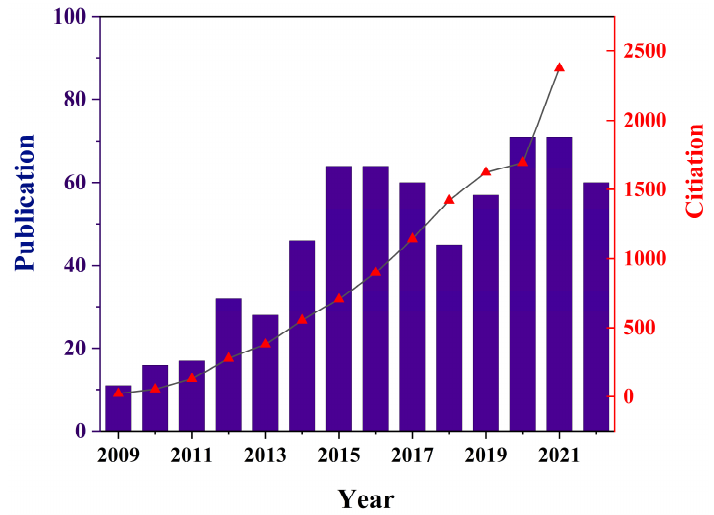
Figure 2. The trends of publication and citation with the keywords of magnetic SERS substrate. The data collected were from 2009 to Nov. 2022 according to Web of Science .